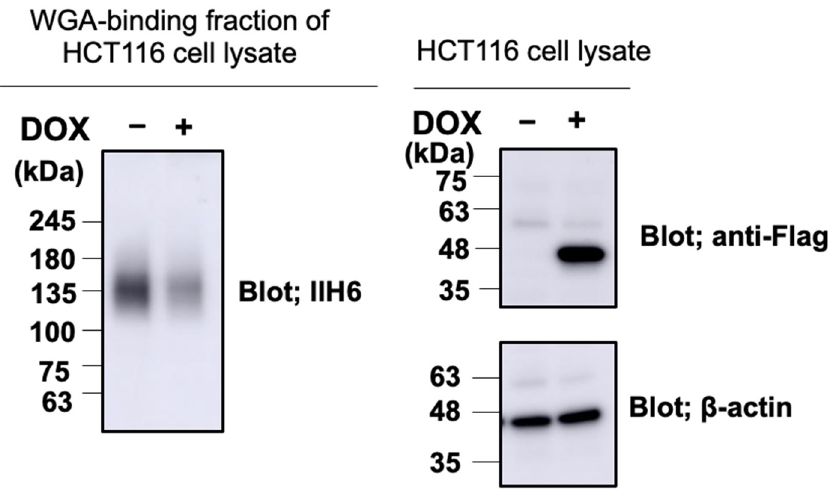
Figure 6. The expression of matriglycans was reduced by PCYT2-overexpression. HCT116 clone stably transfected with the doxycycline (Dox)-inducible PCYT2 construct; − Dox, uninduced cells; + Dox, induced cells. Cell lysates containing equal amount of total proteins prepared from HCT116 cells with (+) or without ( − ) Dox were subjected to immunoblot analysis using anti-Flag antibody and anti- β -actin, or to WGA enrichment followed by immunoblot analysis using IIH6.